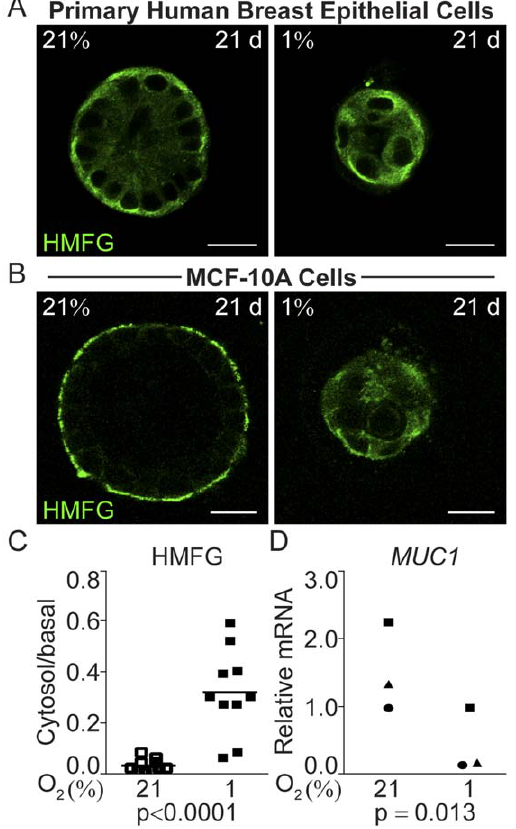
Figure 5. Localization of Human Milk Fat Globule (HMFG) in human breast epithelial cells at normoxia and hypoxia. A. Cellular localization of HMFG (green) in primary human breast epithelial cells after 21 days of 3D-culture on ECM-derived substrate at normoxic (21%) or hypoxic (1%) conditions. Images from one representative of three independent experiments with cells from different individuals are shown. Size bars 20 m m. B. Staining of HMFG (green) on 3D-cultures of MCF-10A cells after 21 days of culture on ECM-derived substrate at normoxic (21%) or hypoxic (1%) conditions. All confocal micrographs were acquired at the Z-plane where the depictured acini-like structure had the widest circumference. Size bars 20 m m. C. The ratio of intra cellular to basal cell membrane mean fluorophore intensity in normoxic (open) and hypoxic (black) MCF-10A cell organoids at 21 days post- seeding, measured in one representative cell in ten different acini-like structures. Statistical analysis was performed with Student’s t-test (p). D. Relative mRNA levels of MUC1 in normoxic (21%) and hypoxic (1%) 3D-cultures of MCF-10A cells 21 days post-seeding, showing data from three independent experiments. Statistical analysis was performed with Student’s paired t-test (p).